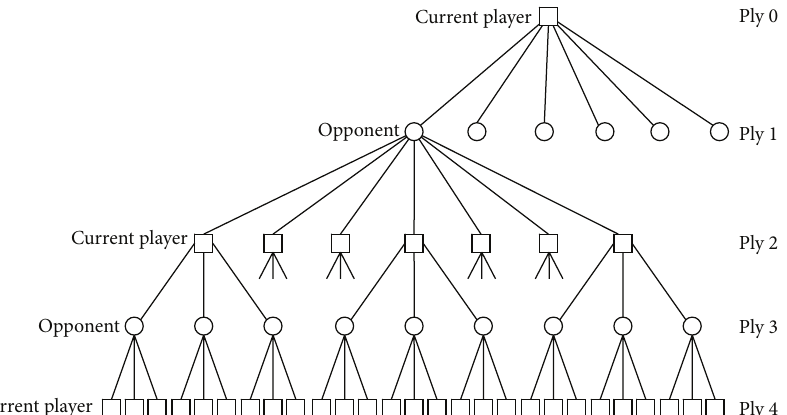
Figure 6: Game tree expanding to ply 4.